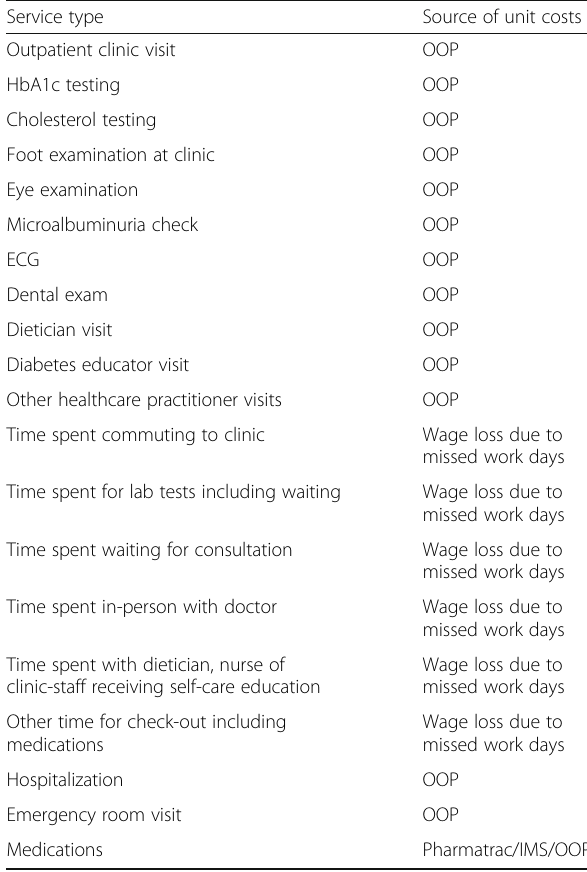
Table 3 Self-reported health services use and sources of data Service